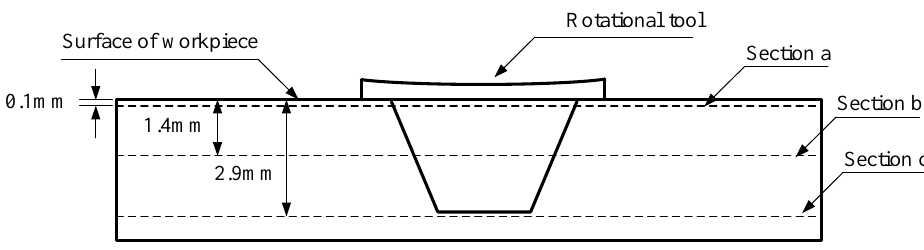
Figure 3. Position of different sections of the